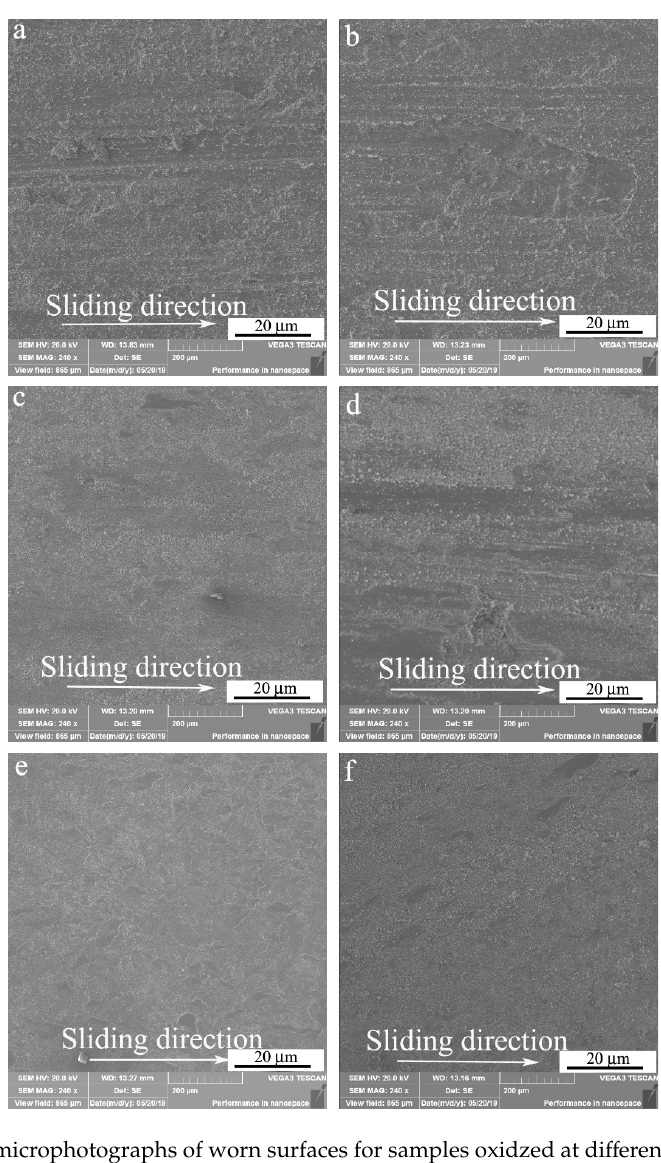
Figure 10. SEM microphotographs of worn surfaces for samples oxidzed at different temperature for 3 h: ( a ) 1240 °C, ( b ) 1260 °C, ( c ) 1280 °C, ( d ) 1300 °C, ( e ) 1320 °C, ( f ) 1340 °C.